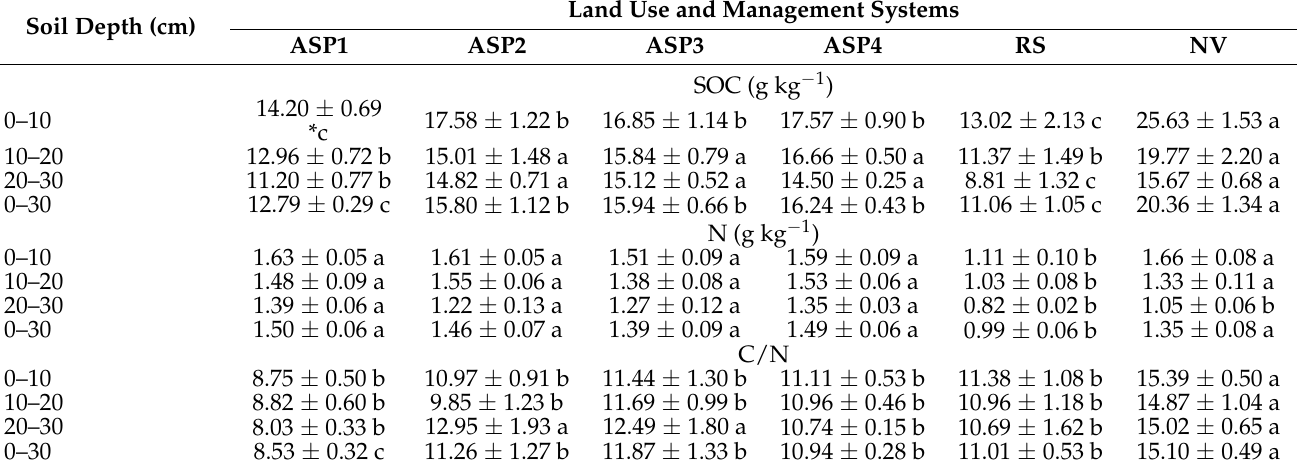
Table 1. Soil organic C and N contents and C/N ratio under different land use and management systems at Bonsucesso farm in Minas Gerais State, Brazil. Systems: E. camaldulensis × E. tereticornis hybrid intercropped with buffel grass using the arrangements 2 × 3 + 10 m (ASP1) and 2 × 3 + 15 m (ASP2); E. urophylla × E. grandis hybrid intercropped with buffel grass using the arrangements 2 × 3 + 10 m (ASP3) and 2 × 3 + 15 m (ASP4); Regeneration stratum (RS); and native vegetation (NV).